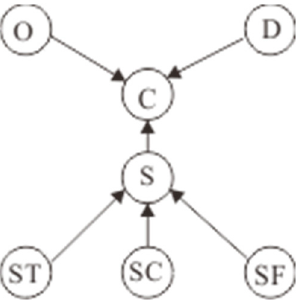
Figure 5. BN topology model.